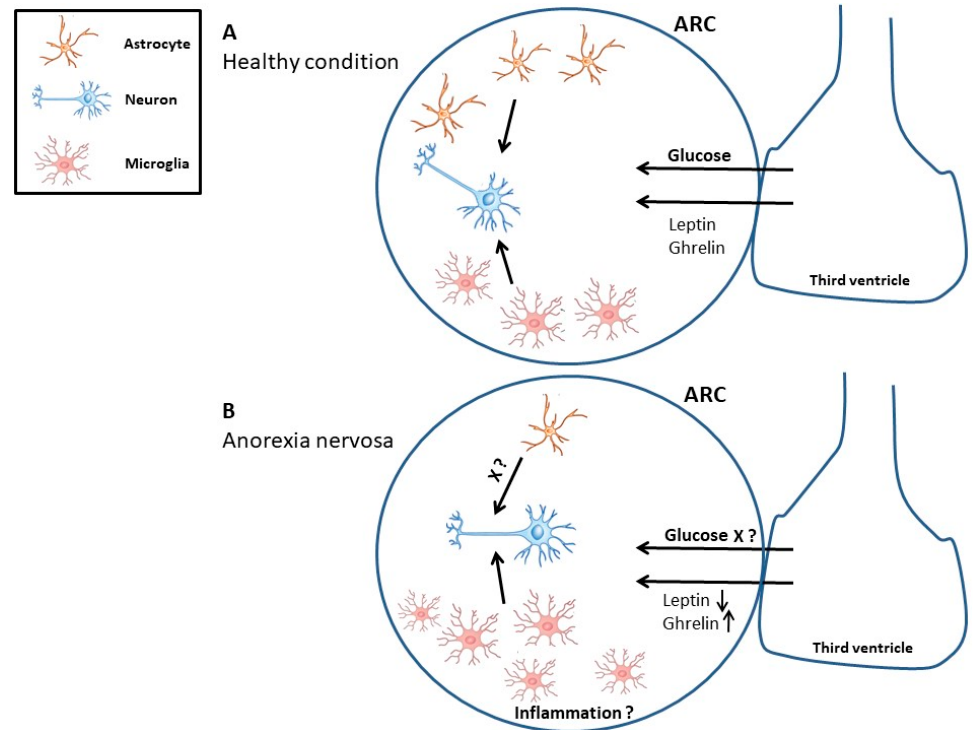
Figure 5. The interaction between neurons, microglia, and astrocytes in the control of food intake. Under healthy conditions, the regulation of food intake resembles a homeostatic interplay of glia cells and neurons ( A ). Astrocytes act for example as glucose sensors and influence plasticity through their contact with synapses. A hypothetic model demonstrates the starvation-induced effects in the hypothalamus in anorexia animal models, e.g., a decrease in astrocyte cell number and function and an increase in microglia cell number as a result of neuroinflammation ( B ). ARC, arcuate